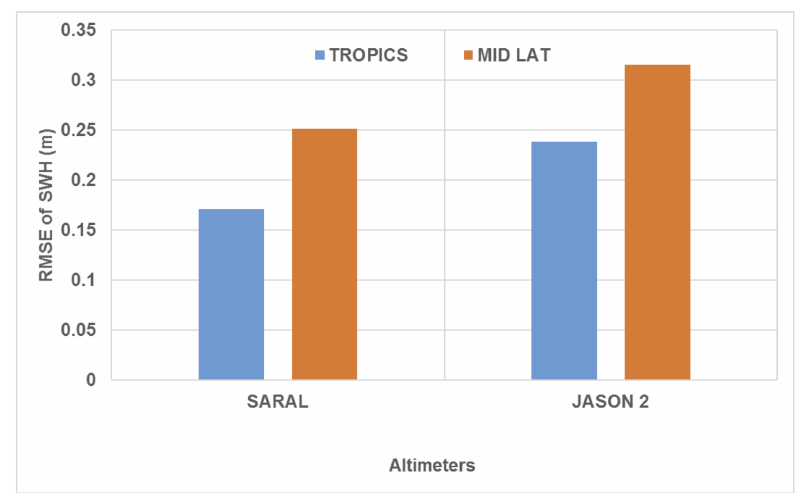
Figure 14. RMSE of SARAL/Jason-2 SWH with respect to buoy observed wave in mid-latitude (30–60 ◦ N) and Tropics (0–30 ◦